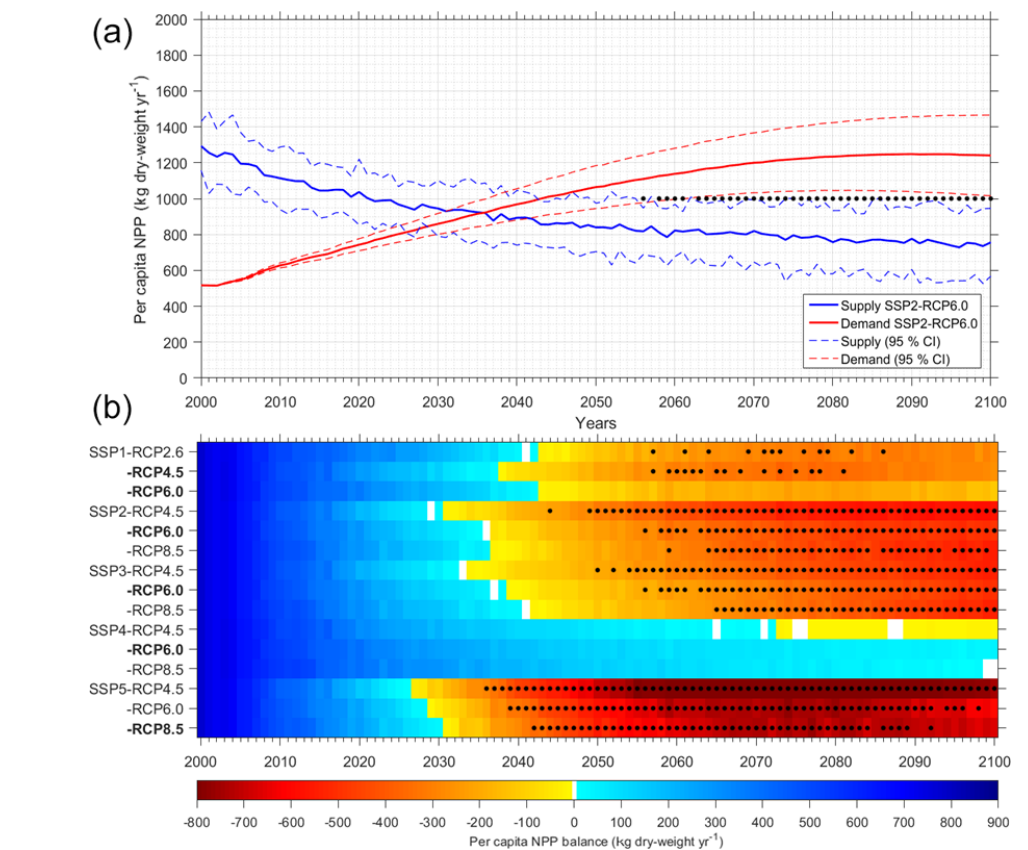
Figure B7. Per capita NPP supply, demand, and balance for the greater Sahel (2000–2100) without CO 2 fertilization. (a) NPP supply (red) and demand (blue). The solid curves illustrate the mean of the SSP2-RCP6.0 combination. The dashed blue curves show supply uncertainty (95% confidence interval around the mean) based on the five GCM NPP results. The dashed red curves show demand uncertainty (95% confidence interval around the mean) based on the uncertainty related to the interpretation and quantification of SSP2. (b) The different magnitudes of the NPP balance and the varying onsets of shortage across all SSP–RCP combinations. Black dots illustrate years with a shortage outside of the 95% confidence intervals. Combinations are grouped according to the socio-economic scenarios ( y axis). The RCPs are ordered from low to high radiative forcing in each SSP group. The temporal trajectory is shown along the x axis and the colouring indicates the sign of the annual NPP balance. Blue shows a surplus of the NPP supply, while yellow to red represents small to very large gaps between supply and demand. SSP–RCP combinations in bold indicate the most likely SSP–RCP pairs based on Table